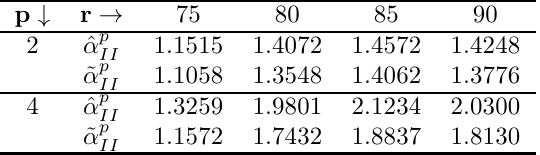
Estimates of powers of α under Type-II